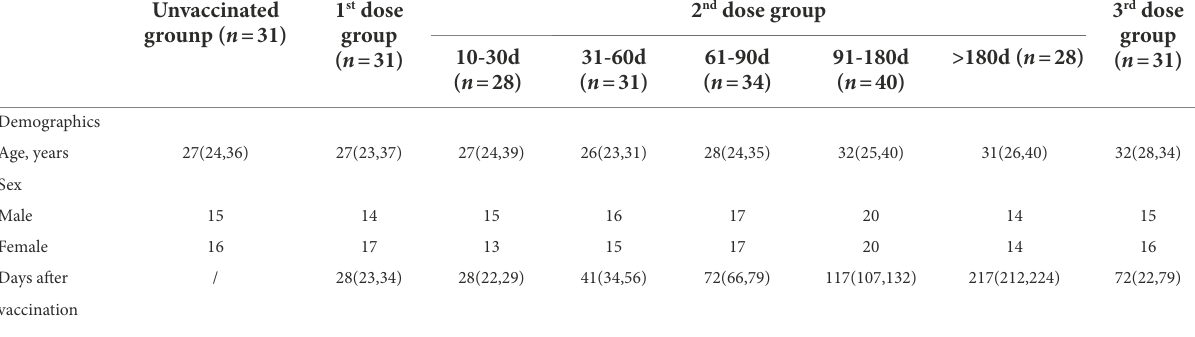
TABLE 1 Demographic and clinical data of